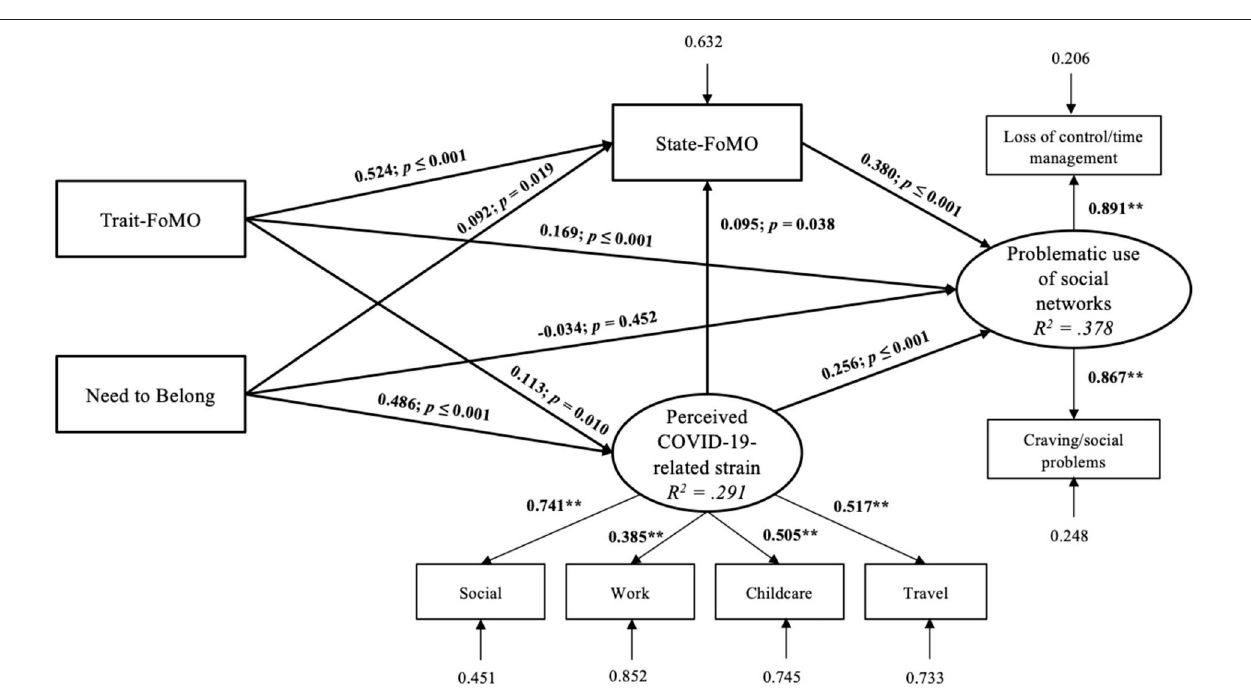
FIGURE 2 | Results of the structural equation model with problematic use of social networks as dependent variable including factor loadings on the described latent dimensions and the accompanying β -weights, p -values, and residuals. The directions of the hypothesized effects are illustrated by the arrows. The rectangles represent the manifest variables, depicted by the subscales of the questionnaires used. The ellipses illustrate the latent dimensions, which are created by the specific manifest variables.